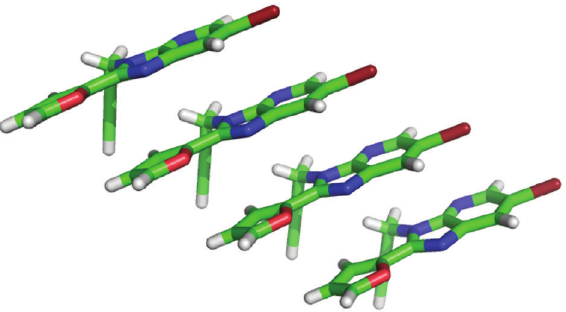
Figure 4: Arrays of parallel aromatic subunits formed by intermolecular 𝜋 - 𝜋 interactions.